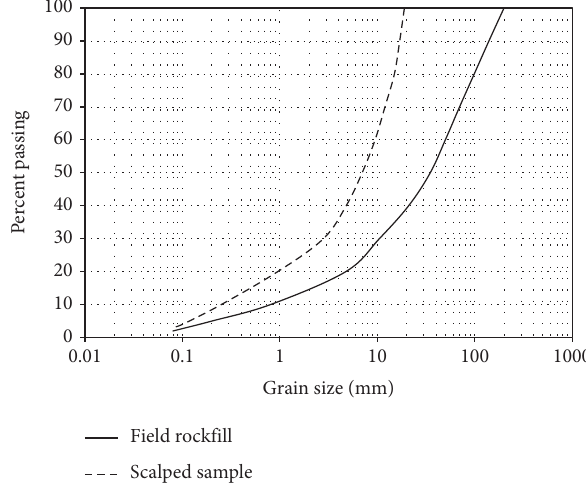
Figure 2: Grain size distribution curves of the field rockfill and scalped sample (data taken from